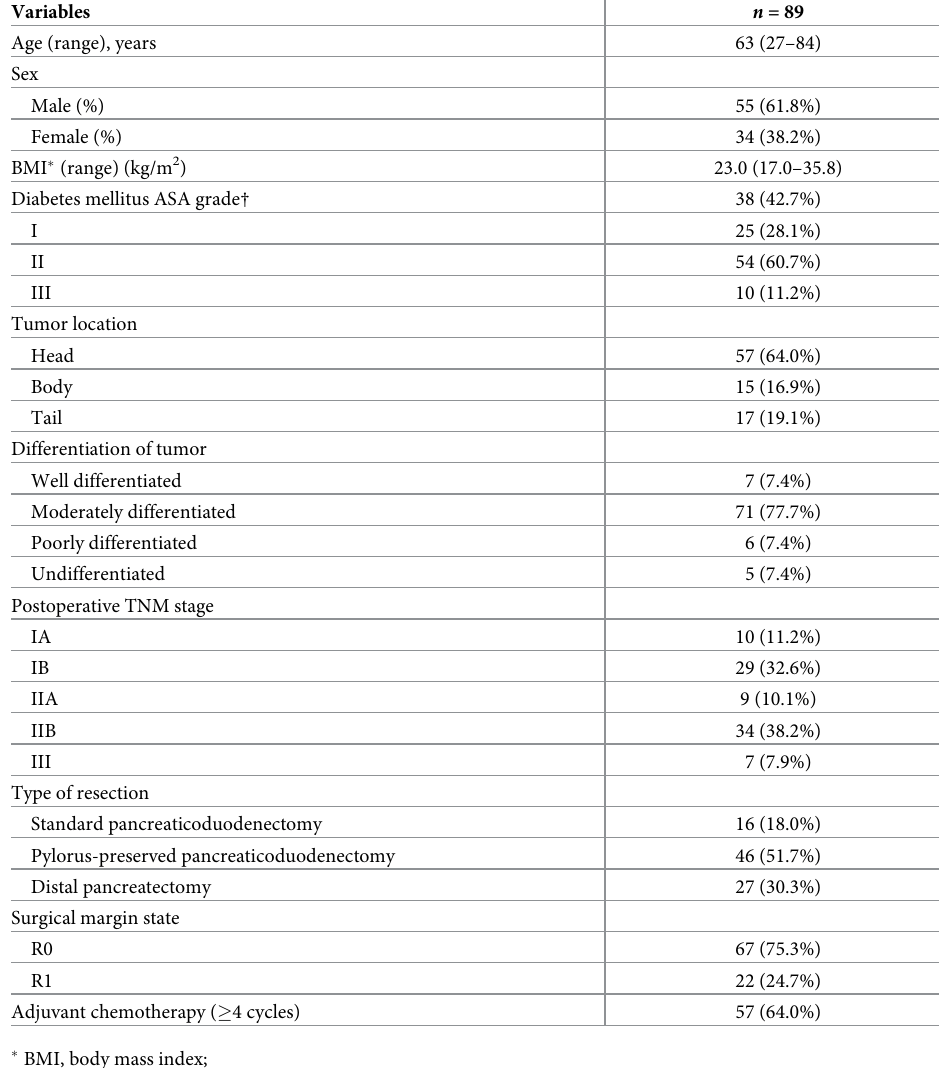
Table 1. Patient demographics and clinical